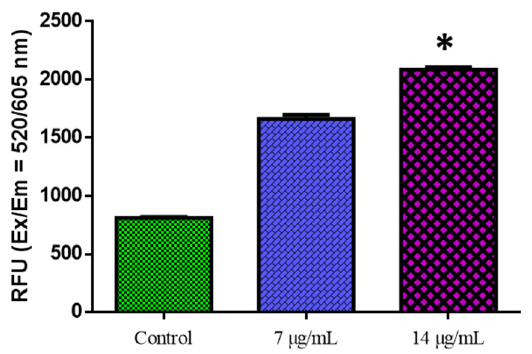
Figure 7. The detection of reactive oxygen species in MOLT-4 cells. MOLT-4 cells were administered for 24 h with or without the IC 50 dose of nanocomposites. The fluorescence signal was measured using the SpectraMax M2 Series Multi-Mode Microplate Reader in bottom read mode at Ex/Em = 520/605 nm (cut off 590 nm) (Molecular Devices). * p < 0.05 compared with control cells. Oxidative stress is typically caused by increased ROS production or decreased ROS clearance, leading to oxidative injury to macromolecules and cells. Though most natural compounds are antioxidants, these compounds can act as pro-oxidants in the tumor cell microenvironment. These chemicals, like resveratrol, are regarded as anticancer pro-oxidant natural products. The potential of CuO-TiO 2 -chitosan-escin nanocomposites to trigger oxidative stress and boost ROS generation in MOLT-4 cells strengthens our findings (Figure